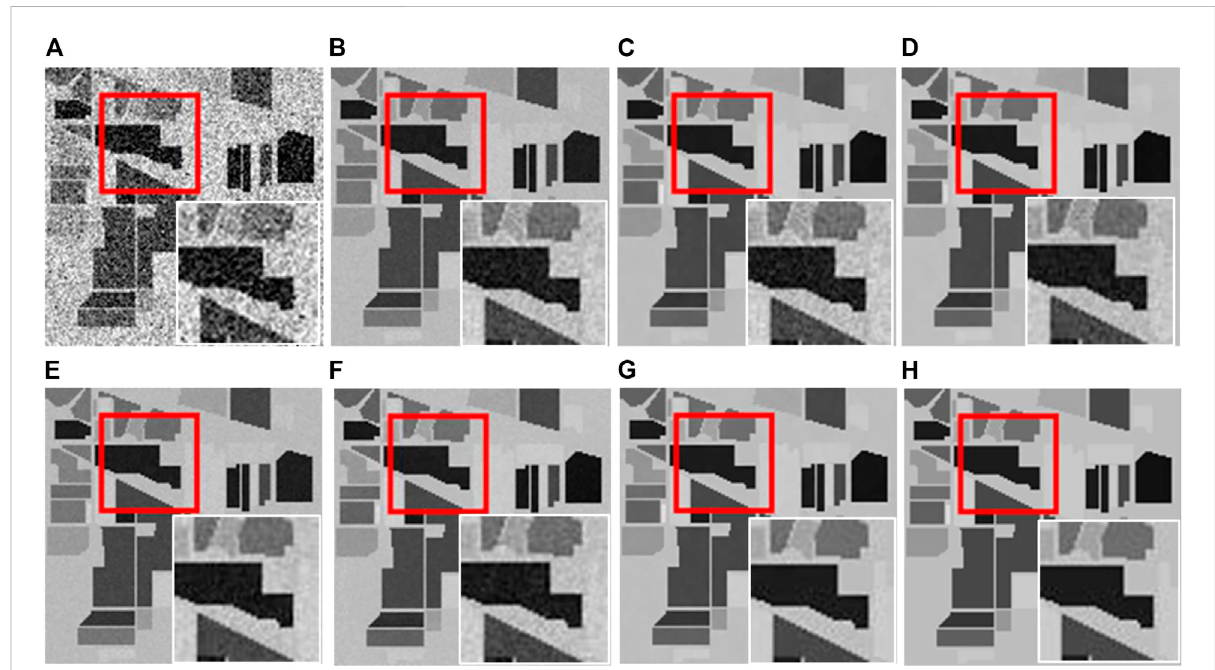
FIGURE 7 Restored results of all comparison methods for band 96 ofINDIAN PINESdata under Case3: (A) Noisy, (B) L 1-2 SSTV, (C) QRNN3D, (D) LRTDGS, (E) SBNTRD, (F) LRTF- L 0 , (G) ANTRRM, (H)